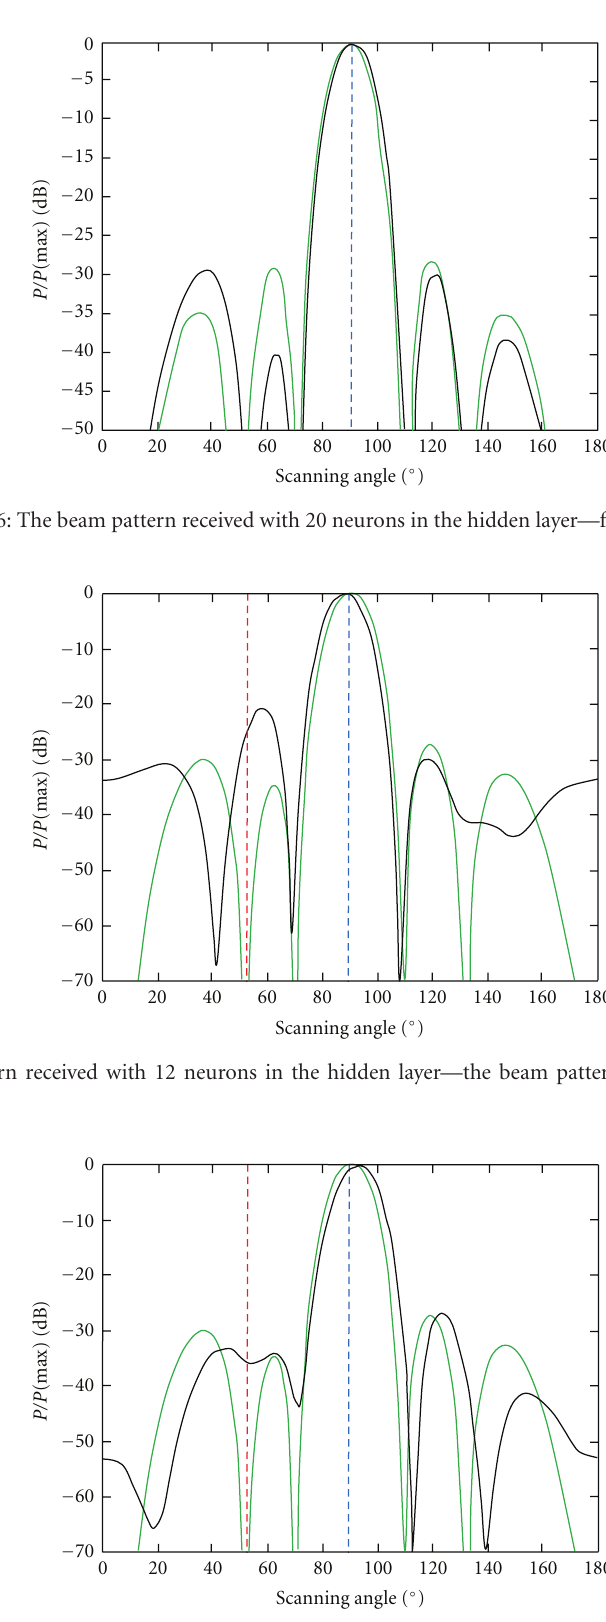
Figure 8: The ANN beam pattern received with 14 neurons in the hidden layer—the beam pattern setting to zero on the interference